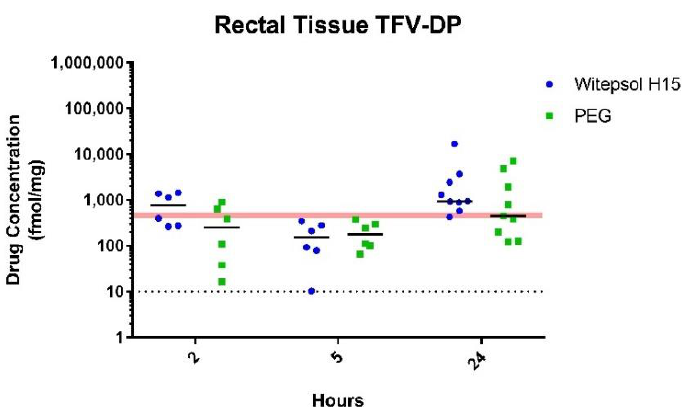
Figure 3. Intracellular TFV-DP levels in rectal biopsies following rectal administration of TFV/EVG (40 mg/40 mg) suppositories formulated in witepsol H15 or PEG base in macaques. Dotted line denotes the lower limit of quantitation (LLOQ). Red shaded line represents levels associated with in vivo protection (82% efficacy).